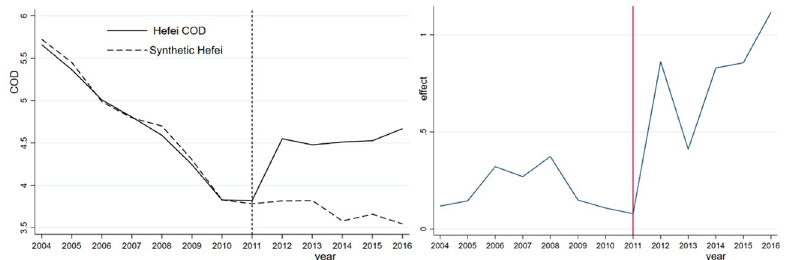
Fig 1. Hefei synthetic COD and its